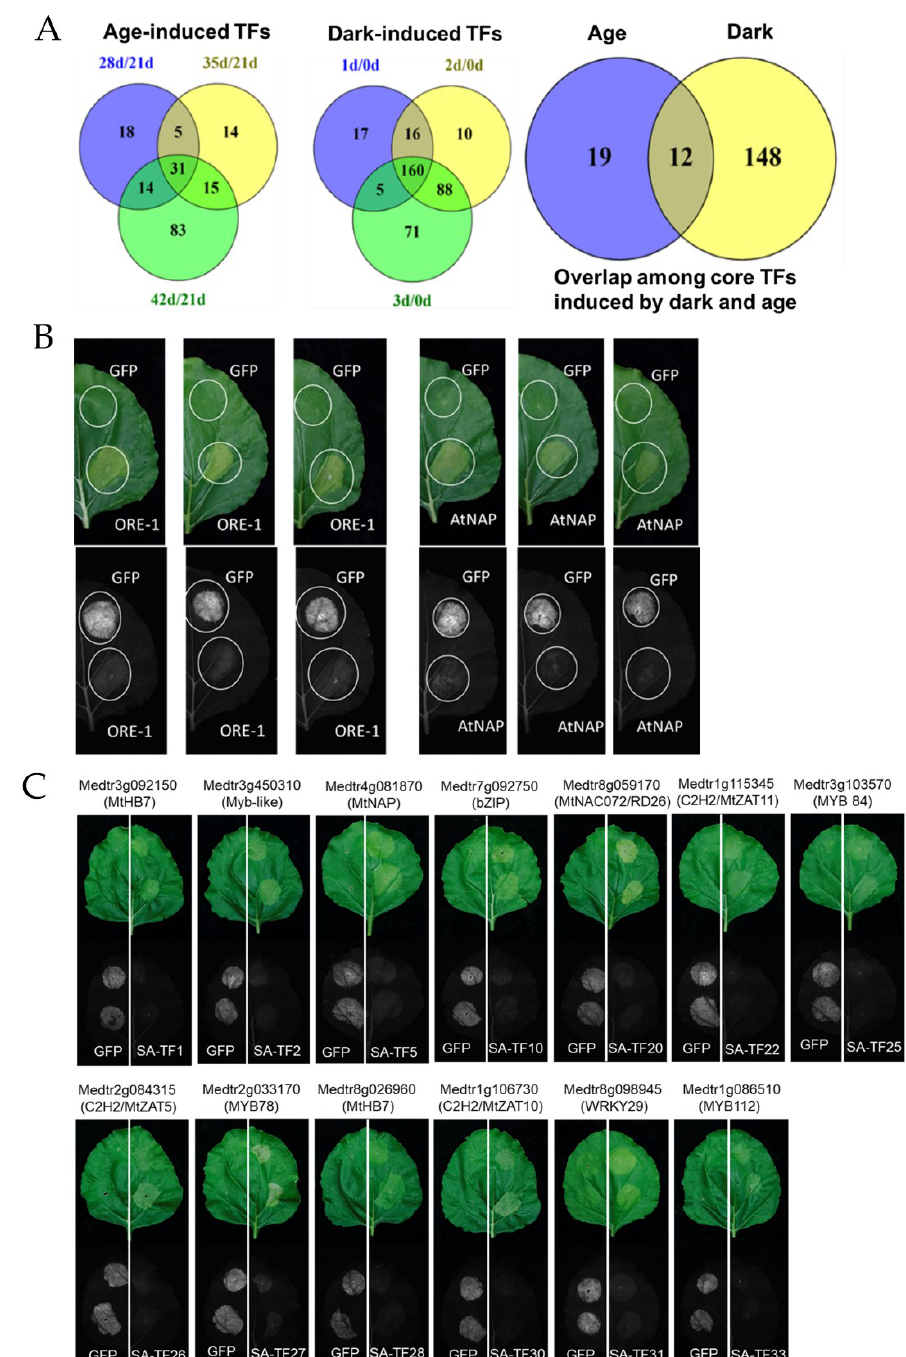
Figure 9. Transient expression of putative senescence-associated transcription factors (SA-TFs). ( A ) Venn diagrams of senescence-induced TFs at different time points in age-dependent and dark-induced senescence. ( B ) Transient overexpression of ORE-1 and AtNAP (35S:TFs) in tobacco leaves through the agroinfiltration method. Expression of GFP under 35S promoter was used as a positive control for gene expression and negative control for senescence induction. ( C ) SA-TFs were cloned into expression vectors under 35S CaMV promoter and transiently expressed in tobacco leaves using the agroinfiltration method. Leaves were photographed six to seven days after infiltration.